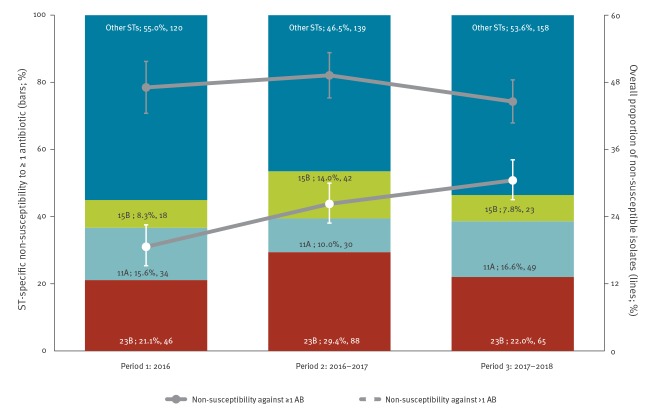
Non-susceptibility against at least one (n = 463 isolates in 2016, 607 in 2016–2017, 662 in 2017–2018) or more than one (n = 462 isolates in 2016, 609 in 2016–2017, 666 in 2017–2018) of the tested antibioticsa and the dominating serotypes among strains of Streptococcus pneumoniae non-susceptible to at least one antibioticb, Belgium, 2016–2018